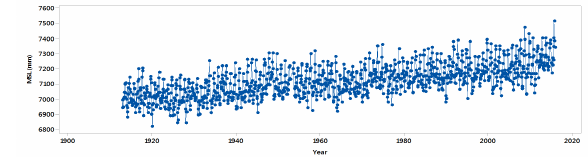
Figure 2: Key-West Monthly tide gauge data.